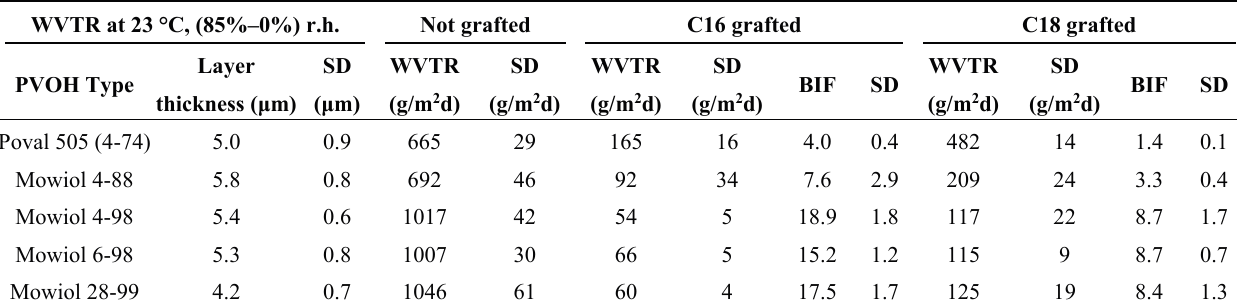
Table 4. WVTR (water vapor transmission rate) at 23 °C and 85%–0% r.h. before and after C16 and C18 grafting and corresponding BIF (water vapor barrier improvement factor) on different PVOH type-coated CEL